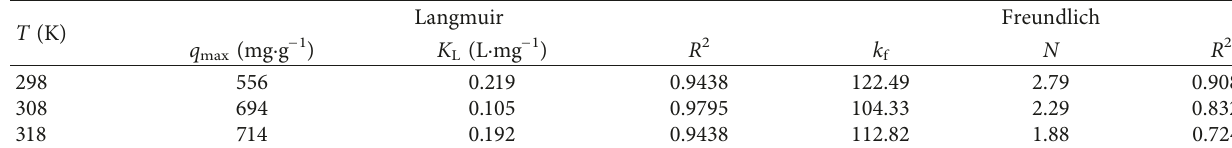
Table 3: Adsorption isotherm parameters of ZIF-8/GO powder.